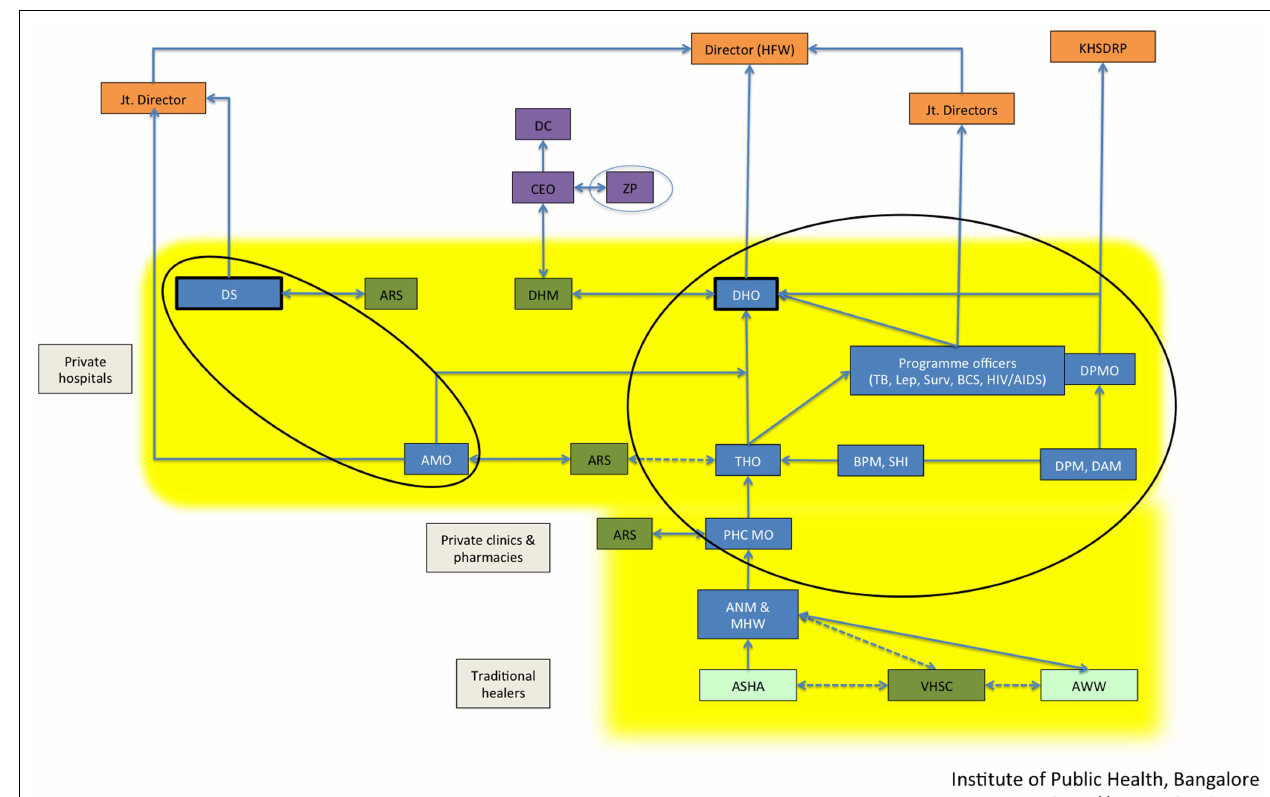
FIGURE 6 | Mapping of the actors in the Karnataka district health system showing their reporting relationships .The various actors – state level officials (orange boxes), district administration (purple boxes), community participation platforms under NRHM (green boxes), health managers and health workers (blue boxes), other village-level health workers (light green), and private healthcare providers (gray boxes) – are shown.The actors targeted in the capacity-building intervention are circled.The yellow background indicates district health services. Abbreviations (in alphabetical order): administrative medical officer (AMO), Anganwadi worker (AWW),